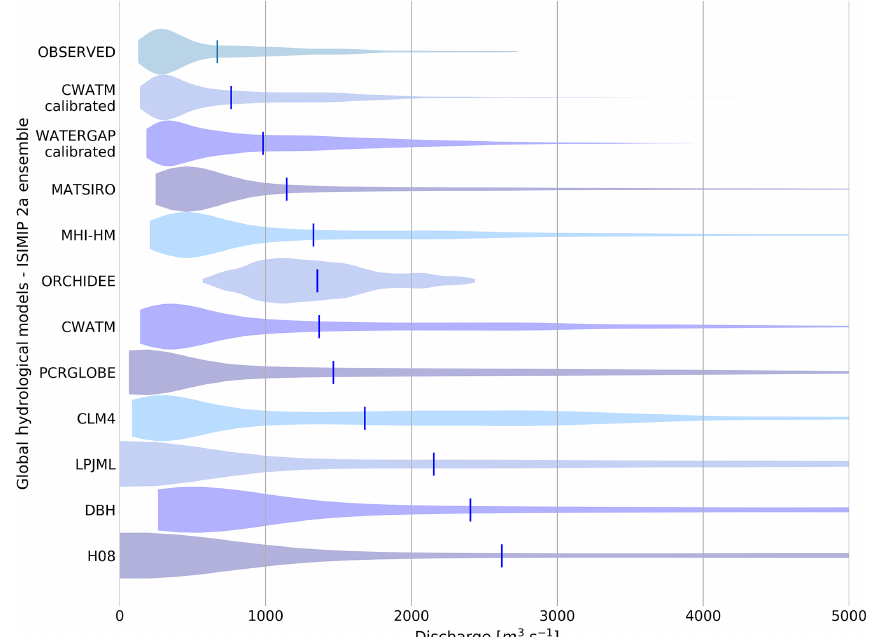
Figure 10. Discharge for Lukulu/Zambezi from 1981 to 2004 for 11 different global hydrological models from the ISIMIP 2a ensemble compared with observed discharge. Each violin plot shows the probability density of the data for the different GHMs. The lines show the average discharge for each